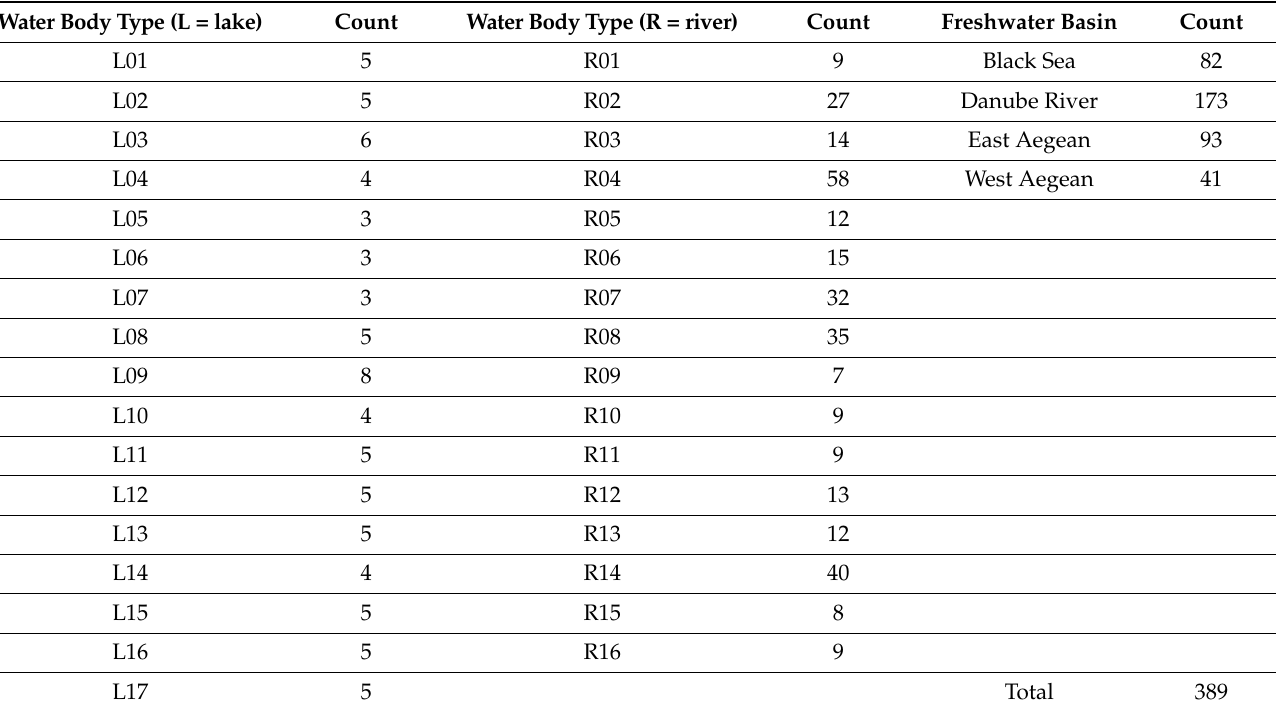
Table 1. Count of sampling points for the determination of type-connected referent fish. communities and biozonation in the Bulgarian freshwater bodies and basin directories/watersheds, according to the classification of Cheshmedjiev et al., 2010